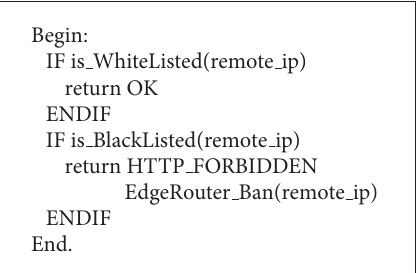
Algorithm 5: Whitelist and blacklist checking in the FAEB algo- rithm.